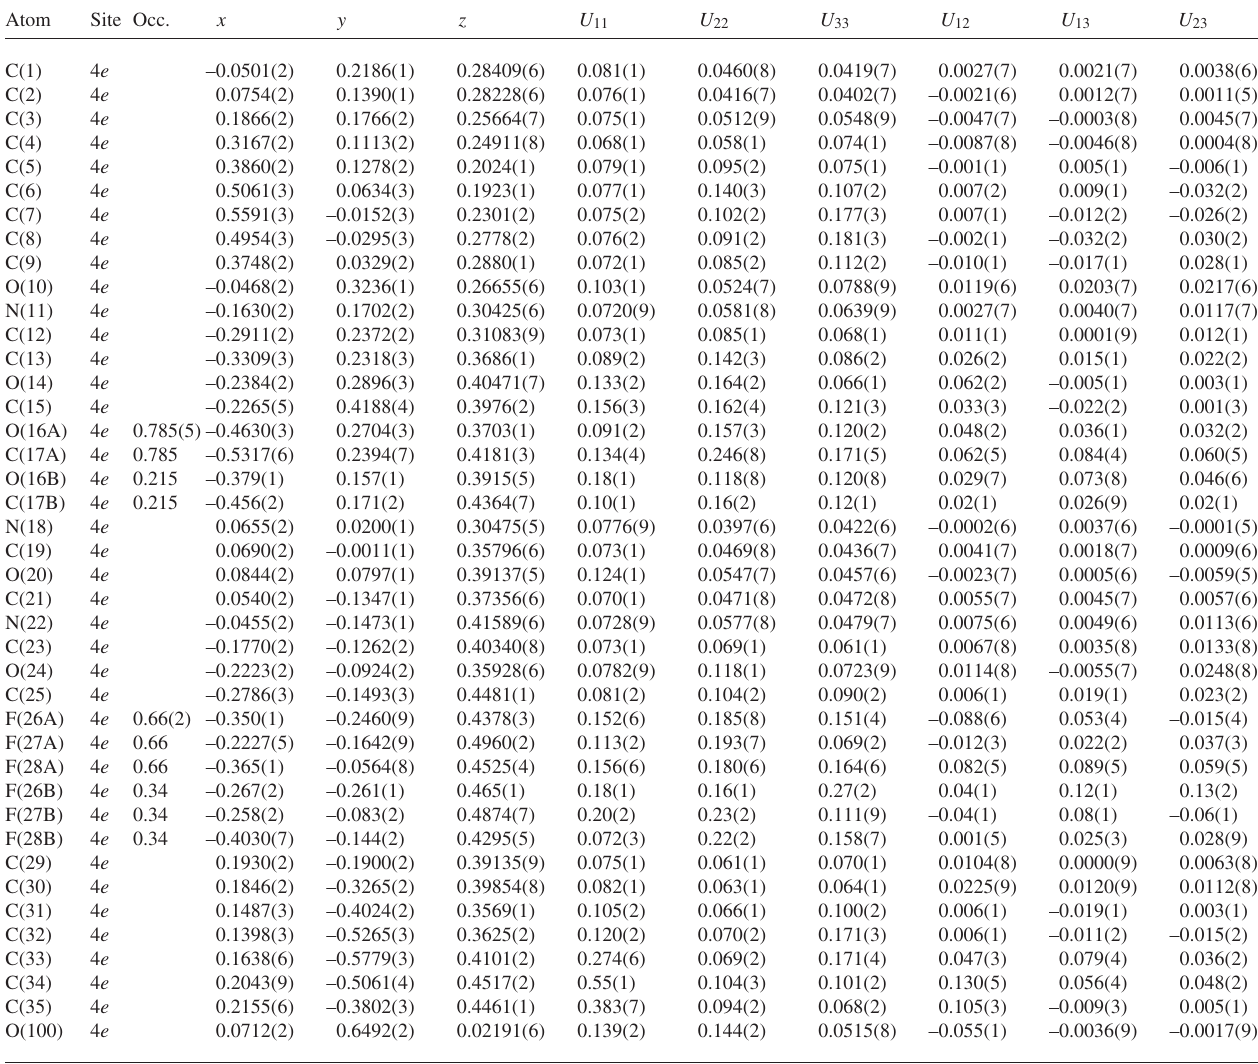
Table 3. Atomic coordinates and displacement parameters (in Å 2 ) .